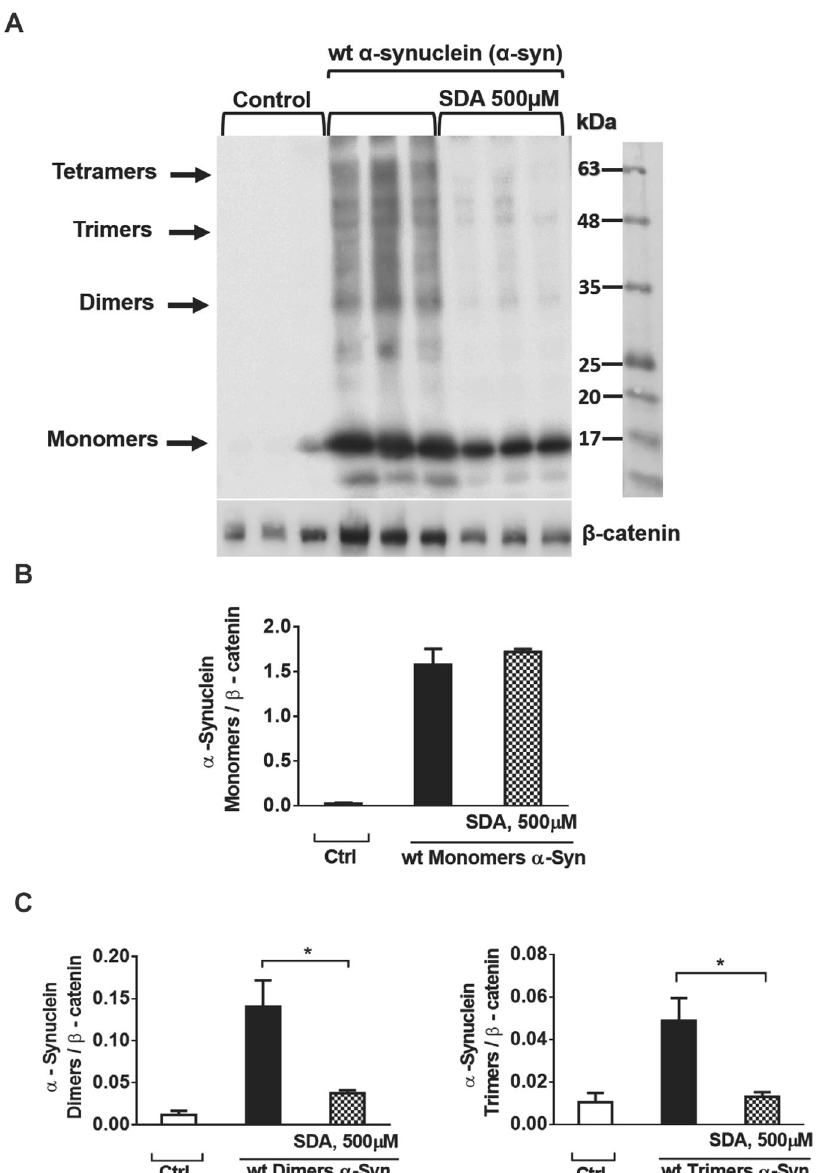
Fig. 8 SDA lower accumulation of dimer and trimer forms of α -synuclein in HEK293 overexpressing α -syn. HEK293 cells were transfected with wt α -syn, and 24 h later washed, and treated with or without 500 μ M SDA and incubated for additional 24 h. The cells were lysed 48 h after transfection and heated to 65 °C overnight. A Equal amounts of protein were loaded and separated on 12% SDS-PAGE. α -syn was determined by immunoblotting using the corresponding α -syn antibody. Control represents non-transfected cells. B Quanti fi cation of α -syn monomers normalized to β -catenin. C Quanti fi cation of α -syn dimers and trimers normalized to β -catenin. The amount of each band was quantitated by densitometry and plotted with a linear regression program. The values shown are average (±SEM) of an experiment consisting of triplicates normalized to β